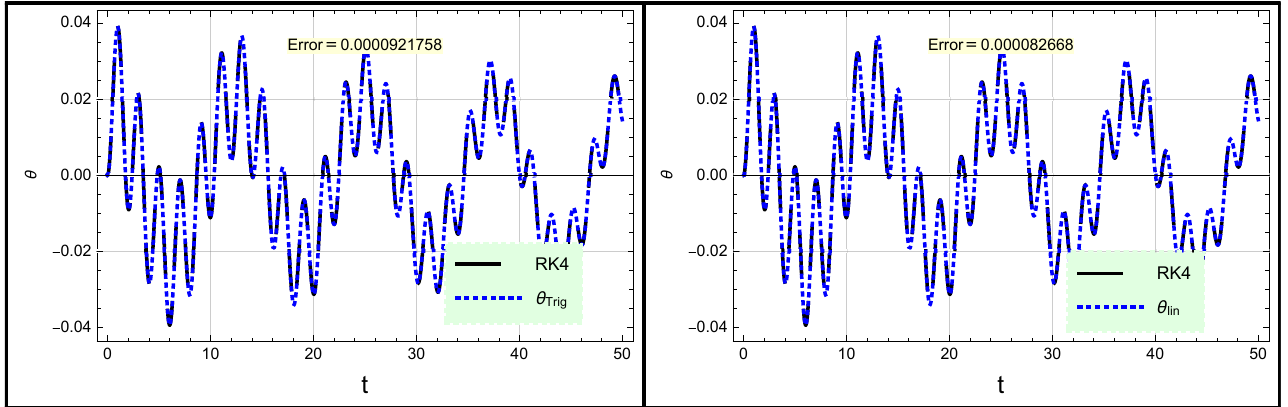
Figure 6. The approximation (30) to the i.v.p. (3) and the exact solution to the i.v.p. (37) are compared with the RK4 numerical approximation to the i.v.p. (3) for ( g , l , ω , Ω , ε , γ ) = ( 9.8,1,0.5,0.1,0.02,0.2 ) (cid:0) (cid:1) = ( θ 0 , ˙ θ 0 and 0,0 )